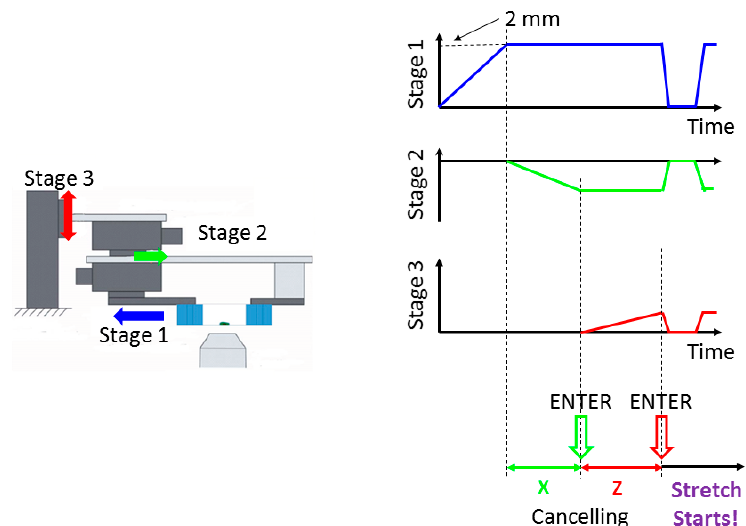
Figure 8. A diagrammatic sketch of the method to determine the maximum displacement values in the horizontal and vertical directions. The C program was used to control the three stages and record the movements of stages 2 and 3 automatically before cyclic stretching. The linear compensation waveforms were formed automatically with the C program for the lengthening, holding, and relaxation phases based on the record. Cyclic stretching was started only after the recognition of the target by human eyes and by pressing the ENTER key.